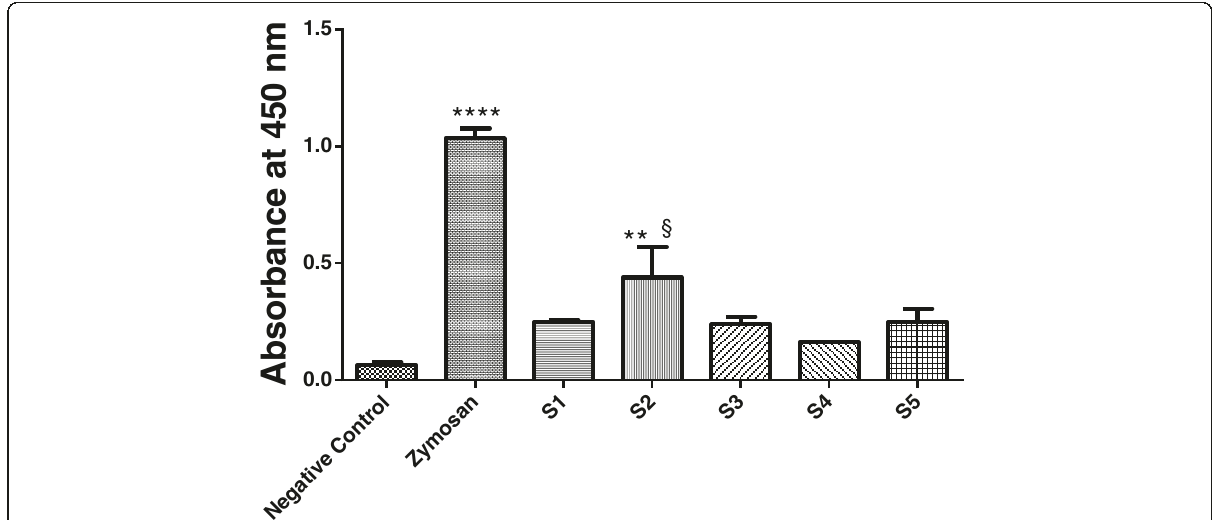
Fig. 6 Formation of the SC5b-9 complex. NHS was incubated for 60 min with PBS (negative control), zymosan (positive control; 1 mg/mL) and fractions S1 to S5. The assay was done using a commercial kit (Quidel SC5b-9 Complement® kit, USA). The columns represent the means ± SEM of one experiment done in duplicate. ** p < 0.01 and **** p < 0.0001 compared to the negative control, and § p < 0.05 compared to